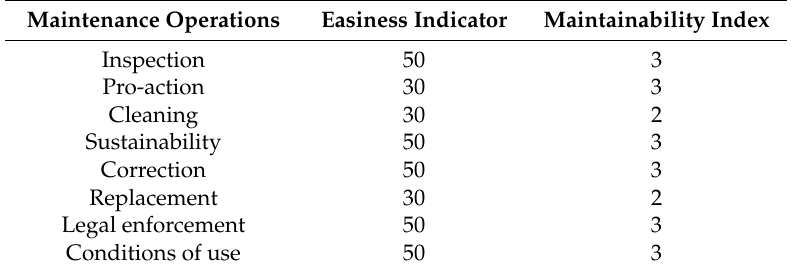
Table 6. Summary of the Eids introduced into the calculation map and the final result through the